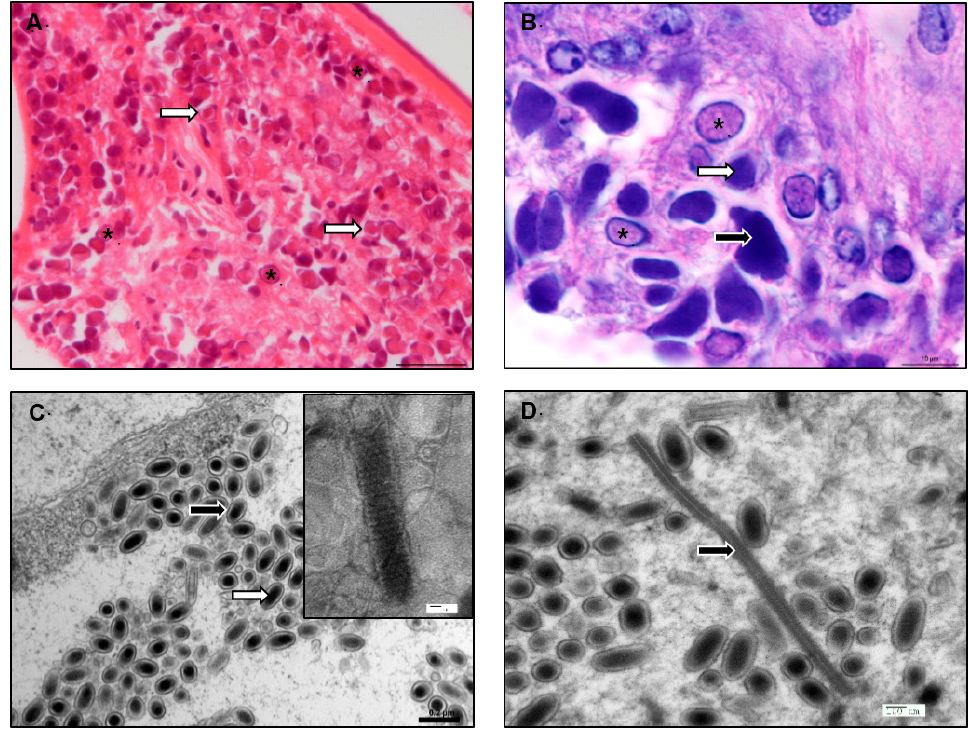
Figure 1. White Spot Syndrome Virus (WSSV) infection of Litopenaeus vannamei . The infection progresses through different stages that can be seen in the nucleus via histology. ( A ) Early-stage infected cells display enlarged nuclei with marginalized chromatin and a homogenous eosinophilic central region. These then develop an intranuclear eosinophilic Cowdry A-type inclusion (*); this can be surrounded by a clear halo beneath the nuclear membrane ( white arrow ). Scale bar = 25 µm; ( B ) The eosinophilic inclusion usually expands to fill the nucleus (*). This inclusion becomes basophilic in staining and denser in color as the infection progresses ( white arrow ). Nuclei then disintegrate so that the content fuses with the cytoplasm ( black arrow ). Scale bar = 10 µm. H&E stain; ( C ) WSSV virions appear ovoid in shape and contain an electron-dense nucleocapsid ( white arrow ) within a trilaminar envelope ( black arrow ). Scale bar = 0.2 µm. Inset. Negatively stained WSSV nucleocapsid, showing the presence of cross-hatched or striated material that is structured as a series of stacked rings of subunits and is a key diagnostic feature of WSSV. Scale bar = 20 nm; ( D ) Presumptive nucleocapsid material within the nucleus prior to envelopment. This material is cross-hatched or striated in appearance and linear prior to its incorporation in the formation of mature WSSV particles. This linear nucleocapsid material is observed sporadically in the manufacture of the WSSV particles. Scale bar = 100 nm. Transmission electron microscopy images.